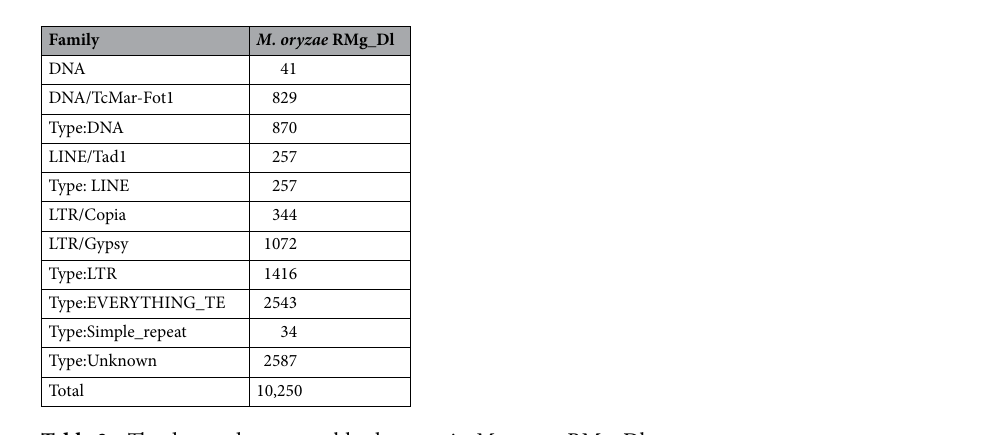
Table 2. The detected transposable elements in M. oryzae RMg_Dl